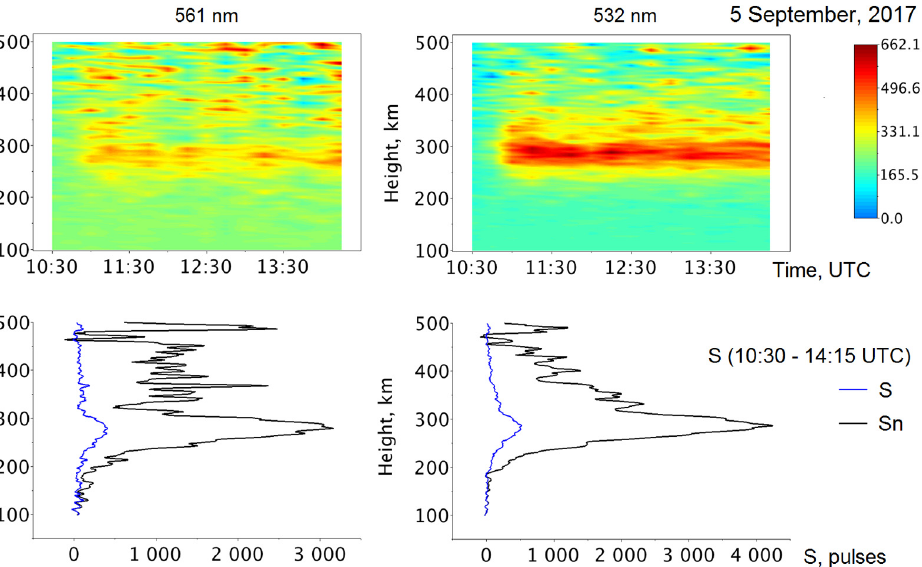
Figure 5. Spatiotemporal distribution of the lidar signals with background noise subtracted for an altitude in the range of 100–500 km (at the top ) and the total signal S (blue curve) and normalized signal Sn (black curve) (at the bottom ), obtained on 5 September 2017.